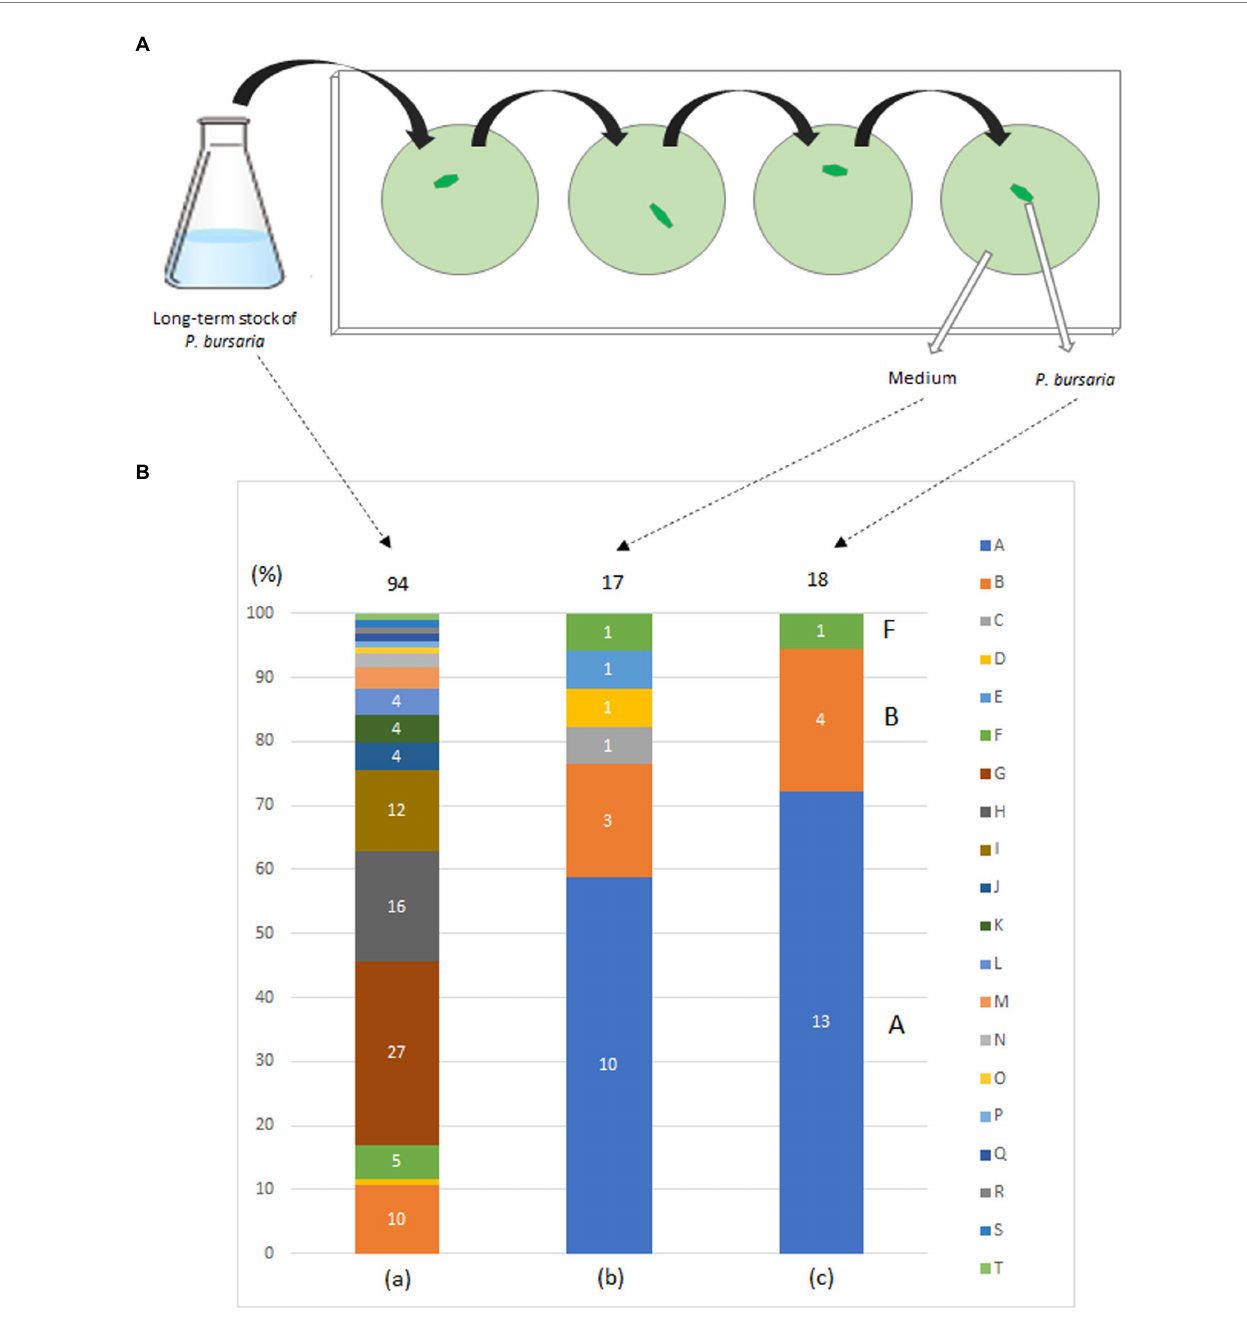
FIGURE 1 Washing procedure (A) and bacterial taxa (B) detected in a fed culture strain of P. bursaria (KUNY-2). (A) A single P. bursaria cell isolated from a fed culture was allowed to swim (1–2 min) in a drop of sterile lettuce medium to wash it from other microbes present. Then, the individual was recovered, placed in a new fresh drop of sterile lettuce medium and allowed to swim to wash it again. The same washing procedure was repeated two more times, and finally the P. bursaria individual and the medium were separately placed and spread on BTB agar plates to grow bacterial colonies. (B) (a) Bacterial colonies in the medium (94 colonies), (b) in the medium after washing the ciliate 4 times (17 colonies), and, (c) in one washed P. bursaria cell (18 colonies). Identified bacteria are color-coded (A–T). Numbers in bar graphs indicate the number of identified colonies per taxon. In (a), when the number of colonies is 3 or less, it is not shown in the bar graph. In (c), A, B, and F indicate bacteria corresponding to A, B, and F among the bacteria identified below. A, Caulobacter sp.; B, Variovorax paradoxus ; C, Chryseobacterium gambrini ; D, Novosphingobium sp.; E, Paracoccus yeei ; F, Variovorax sp.; G, Ancylobacter sp.; H, Aquabacter spiritensis ; I, Kaistia sp.; J, Caulobacter endosymbiont of Tetranychus urticae ; K, Dyadobacter jiangsuensis ; L, Elizabethkingia sp.; M, Pelomonas sp.; N, Microbacterium sp.; O, Leifsonia sp.; P, Microbacterium paraoxydans ; Q, Nevskia sp.; R, Pseudoxanthobacter liyangensis ; S, Sphingomonas sp.; T, Xanthobacter